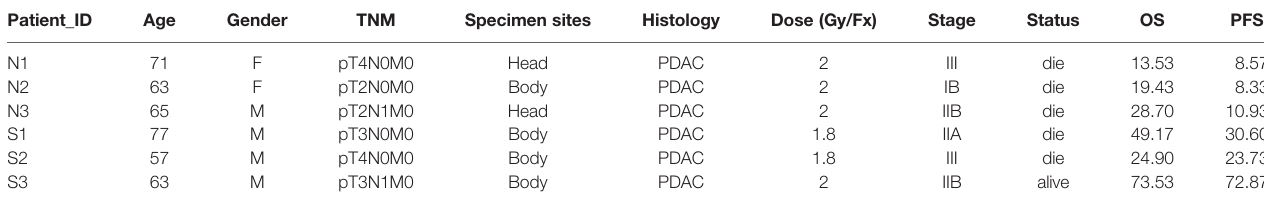
TABLE 1 | Clinicopathological Characteristics of Six Primary Pancreatic Tumor